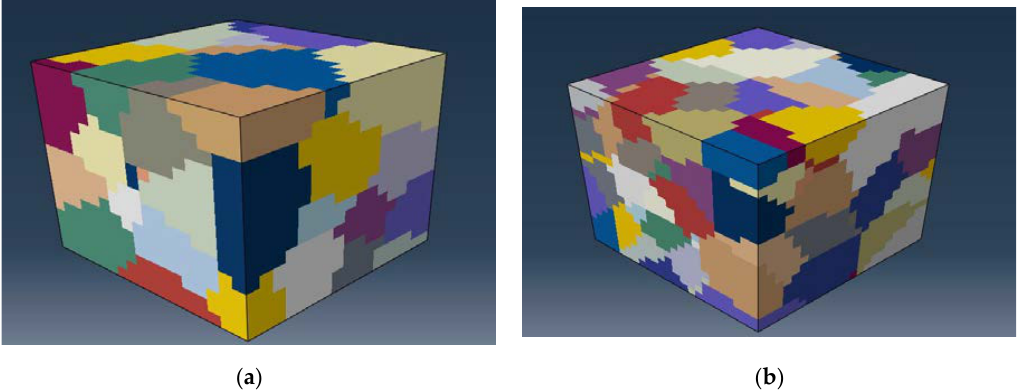
Figure 4. Illustration of representative volume elements generated for ( a ) large grains and ( b ) small grains.